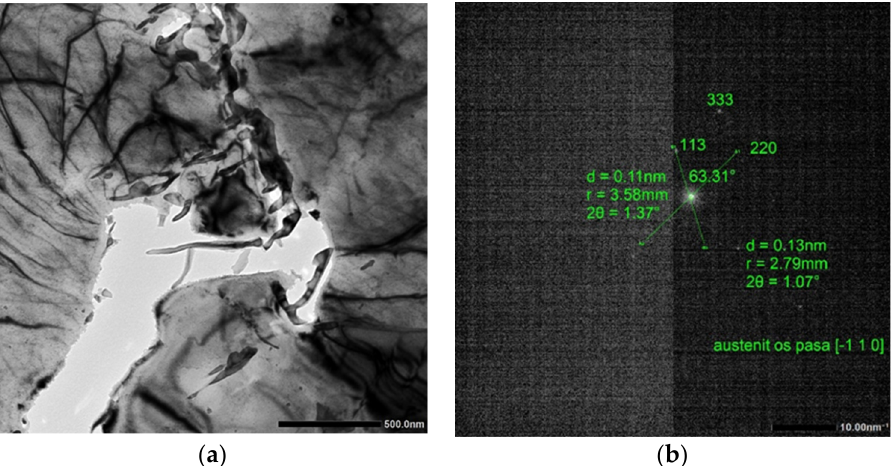
Figure 4. Image of the microstructure for variant 2; ( a ). Ferritic microstructure with visible B + M island, image in the bright field magnification 15 kx; ( b ). Electron diffraction from retained austenite in a martensitic island. Austenite belt axis [1 1 0 ] .